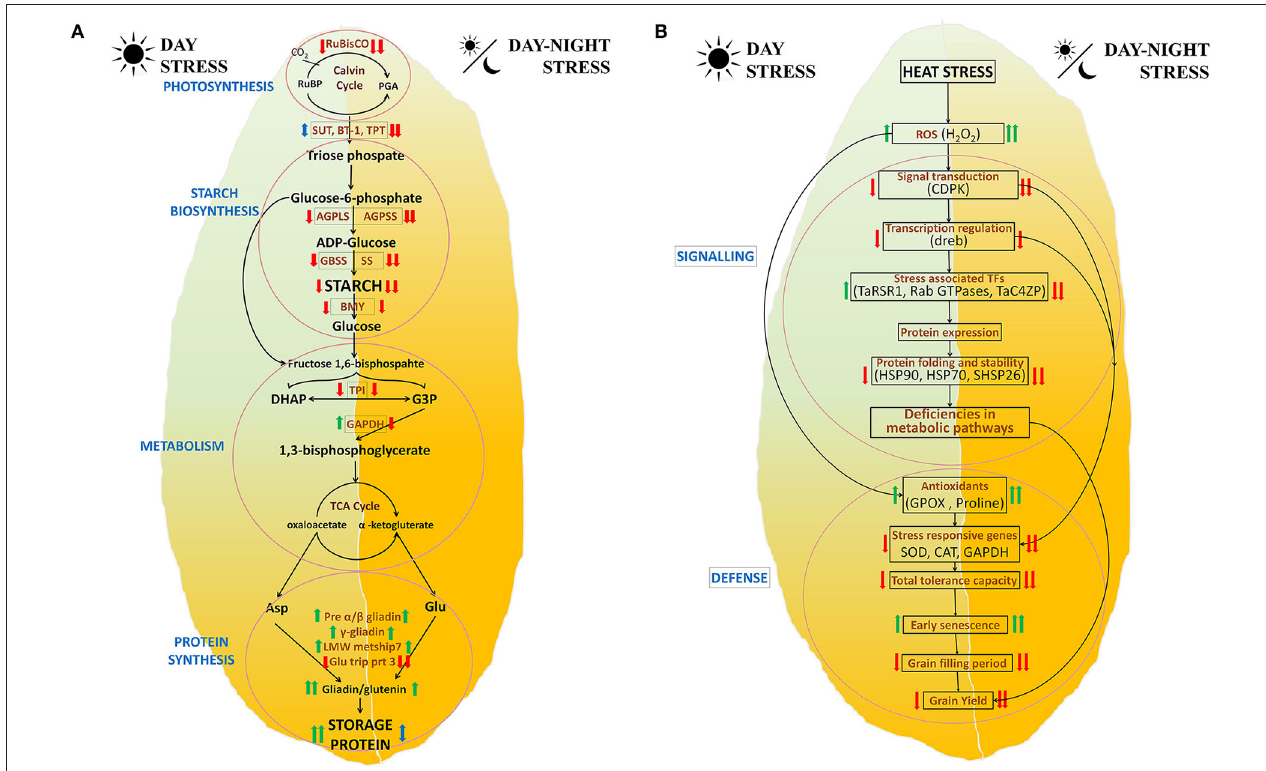
FIGURE 6 | Proposed mechanism of the postanthesis day and day–night heat stress responses in BWL4444. (A) Biosynthesis pathway and (B) stress